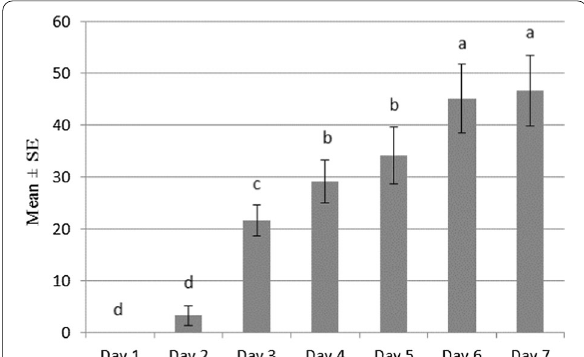
Fig. 5 Mortality of Locusta migratoria migratorioides during 7 Days after treatment with cell-free filtrate of Photorhabdus luminescens (EGAP3). Bars (mean SE in the same and between time intervals ± with the same letter(s) are not significantly different ( P <